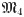
Goodness-of-fit of the Wright-Fisher model M4 with the data of the biological experiments.(A) Correlation between the observed mean frequencies of the five virus variants (averaged over all virus populations and sampling times (mean[fi•(•)]) and their fitted values (n = 75). (B) Correlation between the logarithm of the observed mean (averaged over the variants) standard deviation of variant frequencies (between virus populations) at each sampling date td (1/nvar∑i=1nvarσ[fi•(td)]) and their fitted values (n = 87). In both panels, the black line is the first bisector and the red dashed line is the best-fitting linear model.